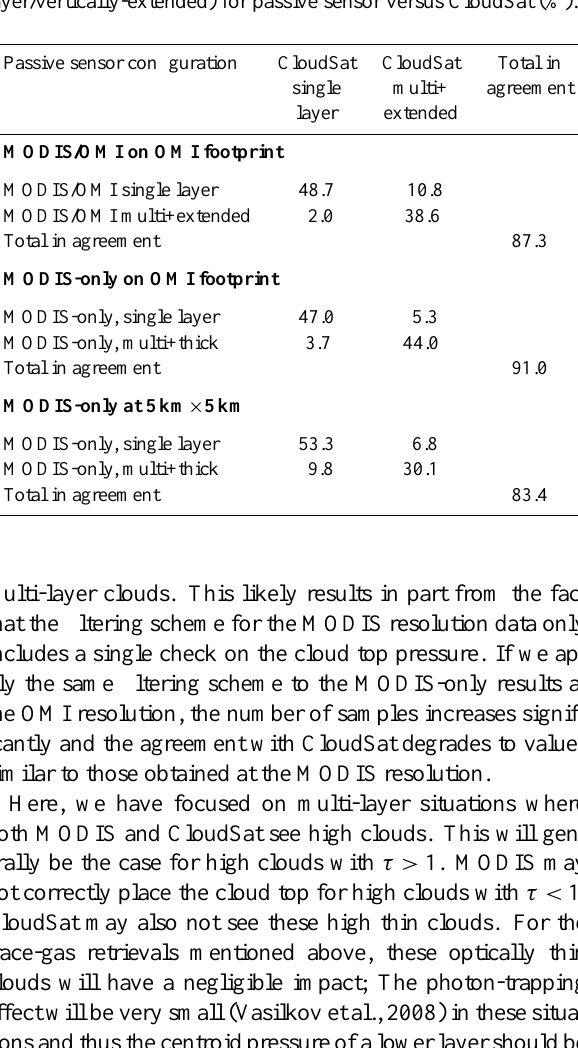
Cloud classification statistics (single or multi- layer/vertically-extended) for passive sensor versus CloudSat